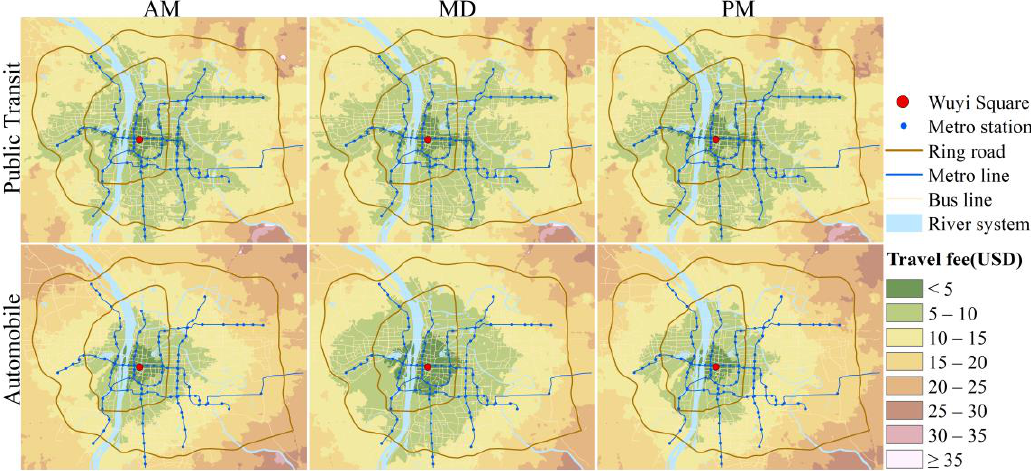
Figure 5. Iso-cost maps of automobile and PT for the three time periods.